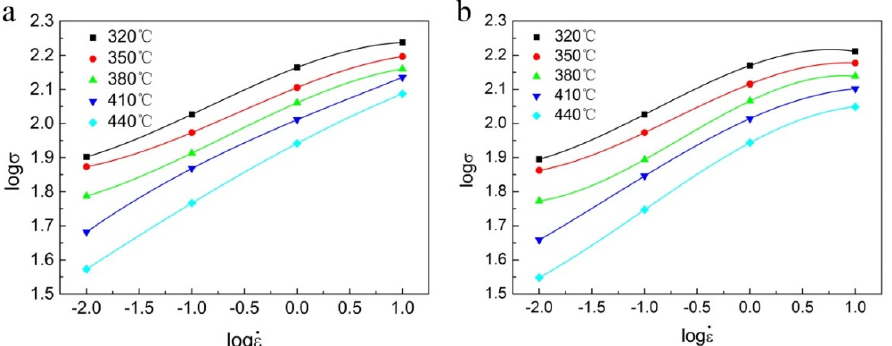
Figure 7. Fitting curves to describe the relationship between log𝜎 and log ε(cid:4662) of Al-Zn-Mg-Cu alloy at strains of ( a ) 0.3 and ( b ) 0.6.